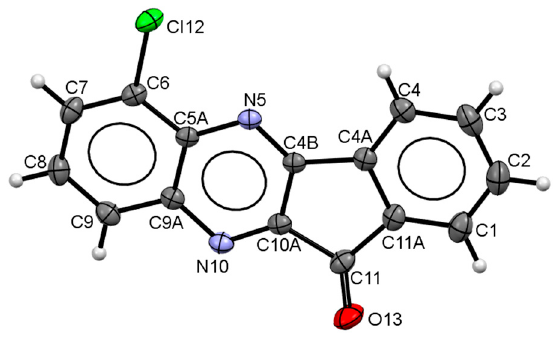
Figure 2. Molecular structure of compound 3b determined by X-ray diffraction analysis.